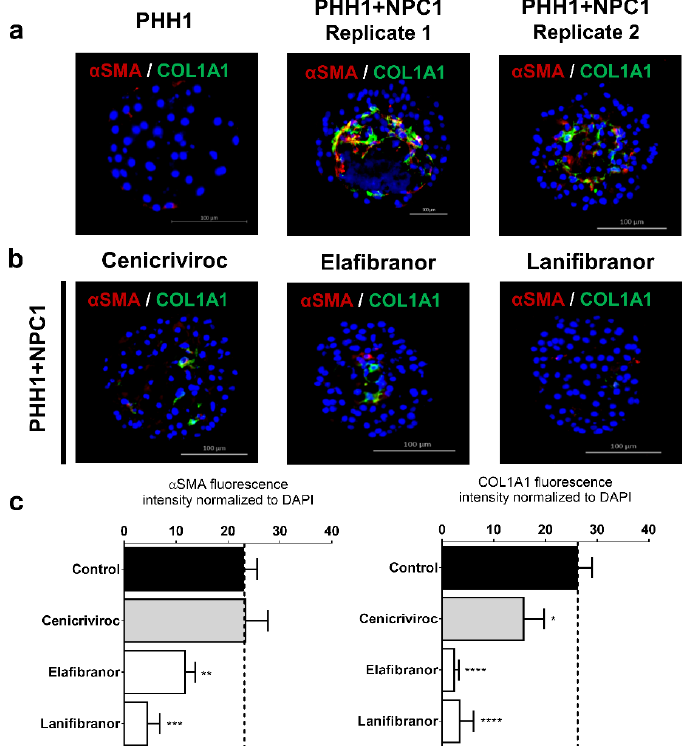
Figure 6. Effects of anti-NASH drugs on the attenuation of COL1A1 deposition in co-culture spheroids. Co-culture spheroids from donor 1 were reproducible in the fibrogenic phenotype ( a ). These spheroids were repeatedly exposed to different anti-NASH drugs, from day 7 to 14, with renewed drug exposure every alternate day. Expression of COL1A1 protein was reduced for cenicriviroc, elafibranor, and lanifibranor ( b ). Quantification (n = 10+) of αSMA and COL1A1 for each drug across replicate experiments ( c ). * p < 0.05*, *** p < 0.001, **** p < 0.0001.